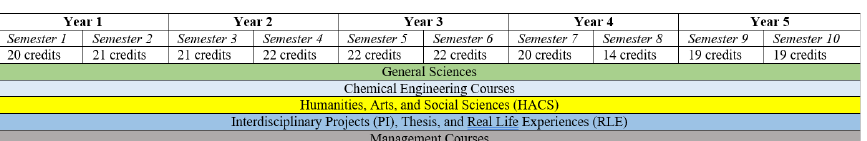
Fig. 1. UTEC curricular mesh with its different transversal